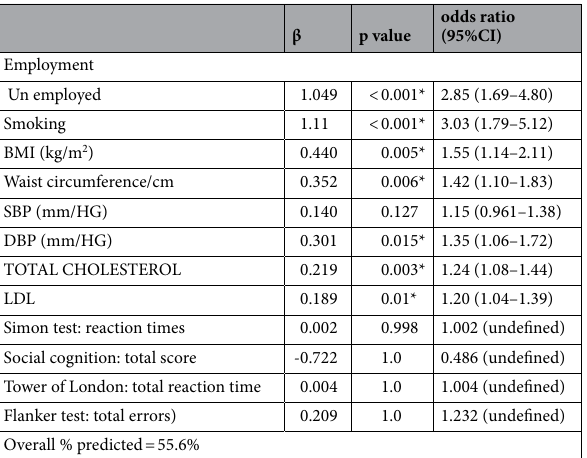
Table 8. Binary logistic regression for prediction of the studied cases. BMI body mass index, SBP systolic blood pressure, DBP diastolic blood pressure, LDL low density lipoprotein, CI confidence